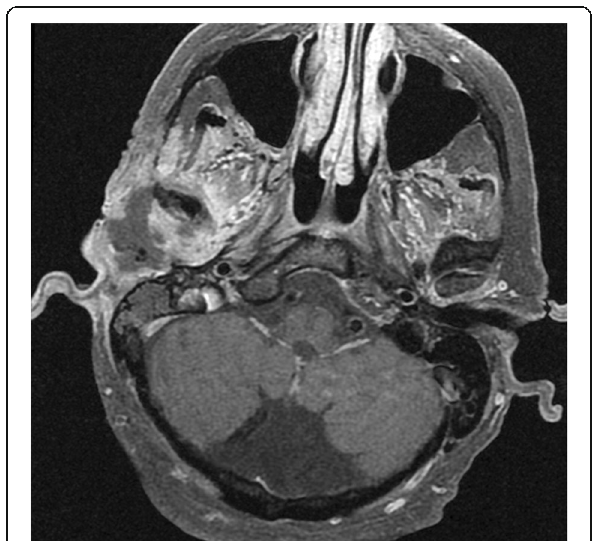
Fig. 10 External auditory canal squamous cell carcinoma. Axial fat- suppressed post-contrast T1-weighted MRI shows an infiltrative and necrotic mass centered in the right external auditory canal with extension into the right temporomandibular joint space